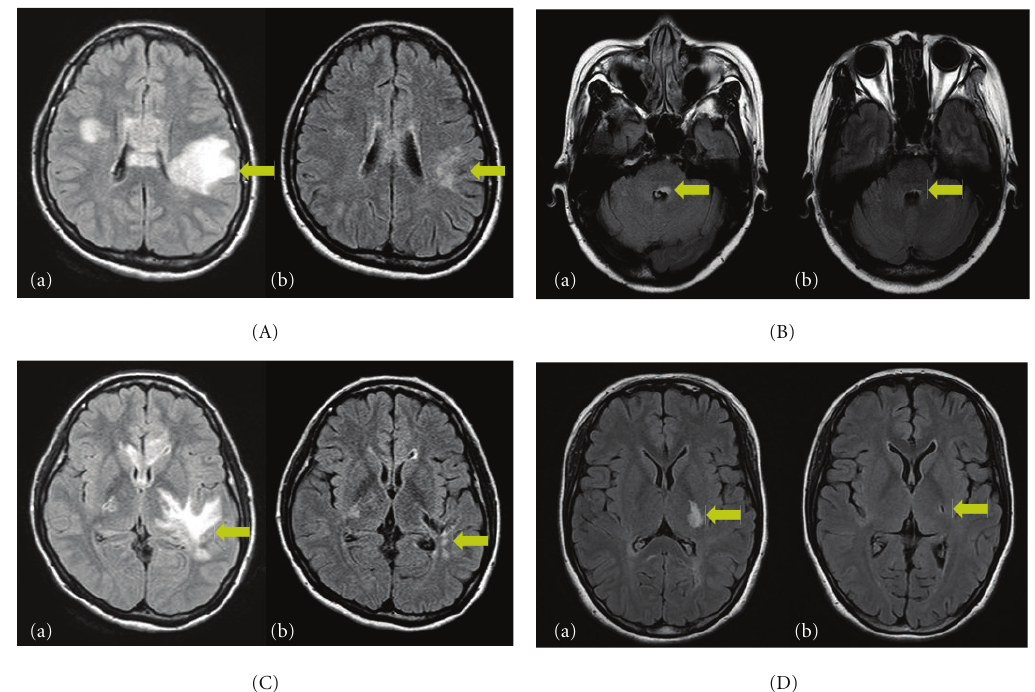
Figure 1: MRI findings at acute manifestation and after symptoms resolved. Fluid-attenuated inversion recovery (FLAIR) abnormalities in a patient with encephalopathy (A-a) and T2 signal abnormalities in a patient with brainstem sign (B-a) almost resolved over a few months (A-b, B-b). However, the lesions involving the corticospinal tracts, especially the posterior limb of the internal capsule (C-a, D-a) showed cavitary changes on followup MRIs (C-b, D-b)